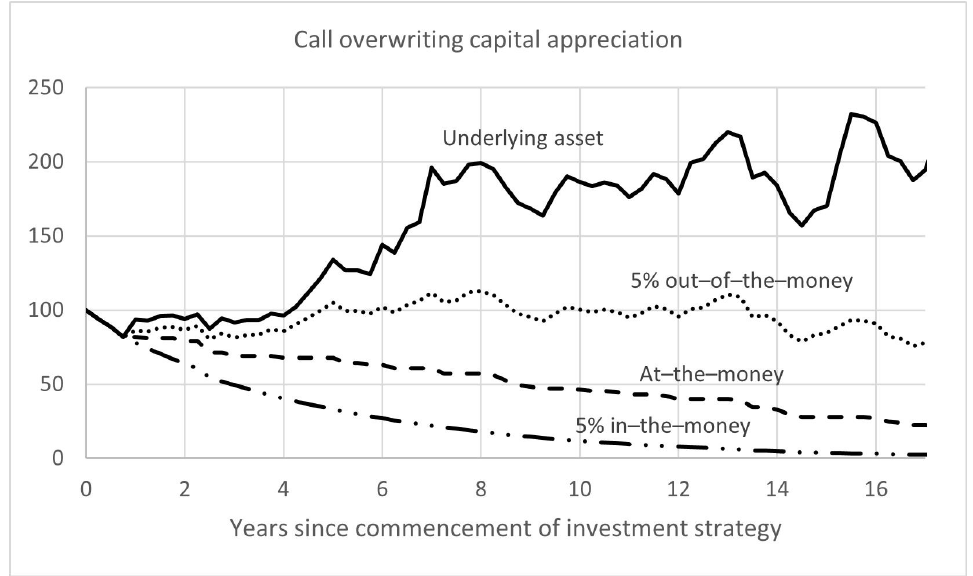
Figure 9. A simulation of the value of an underlying asset overlaid with a call overwriting strategy for 3 strike prices: 5% out-of-the-money, at-the-money, and 5%